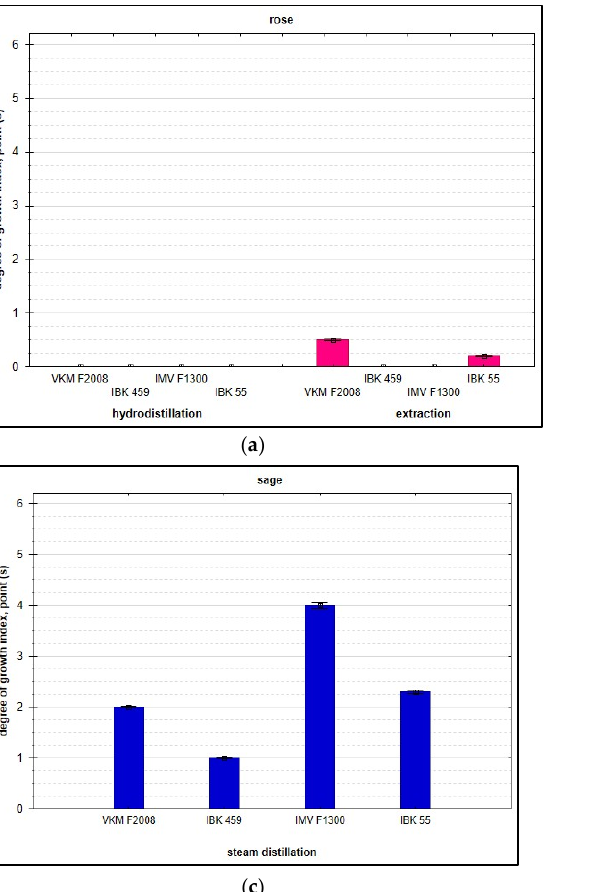
( p = 0.006) and sage ( p = 0.003), and mint occupied an intermediate position (Table 5). The